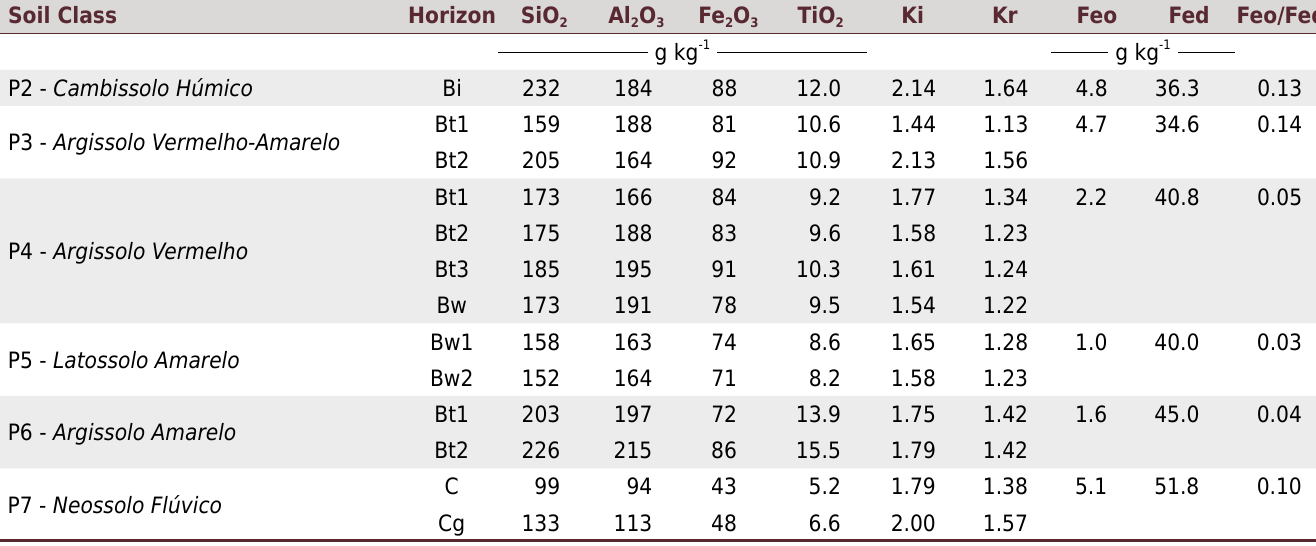
Table 5. Oxides obtained by sulfuric acid digestion and selective extraction of the soils from the Pito Aceso basin, municipality of Bom Jardim (RJ) Soil